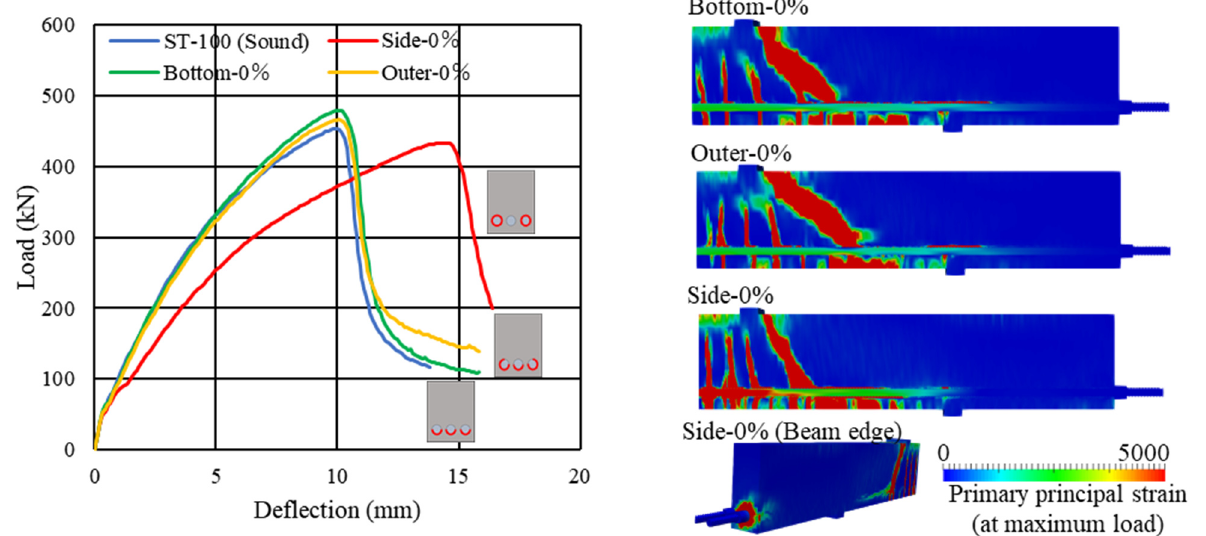
Figure 15. Analysis results (non-uniform lug loss region).